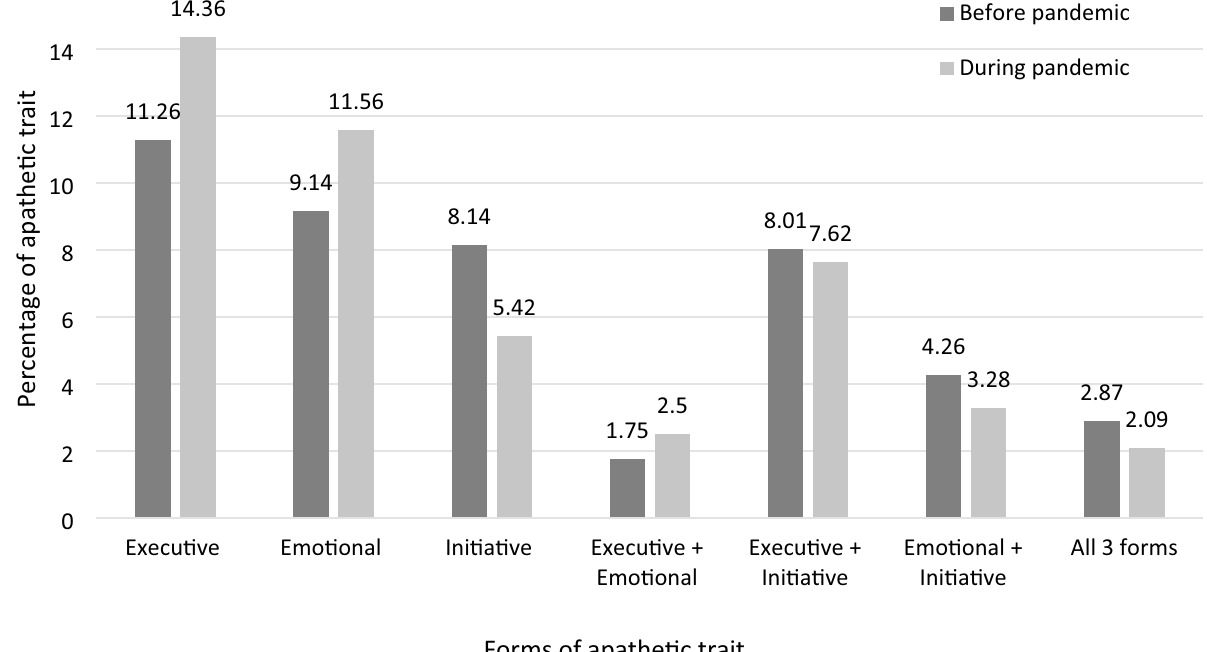
Figure 4. Comparison of combinations of multidimensional apathetic trait in first-year students between before and during the COVID-19